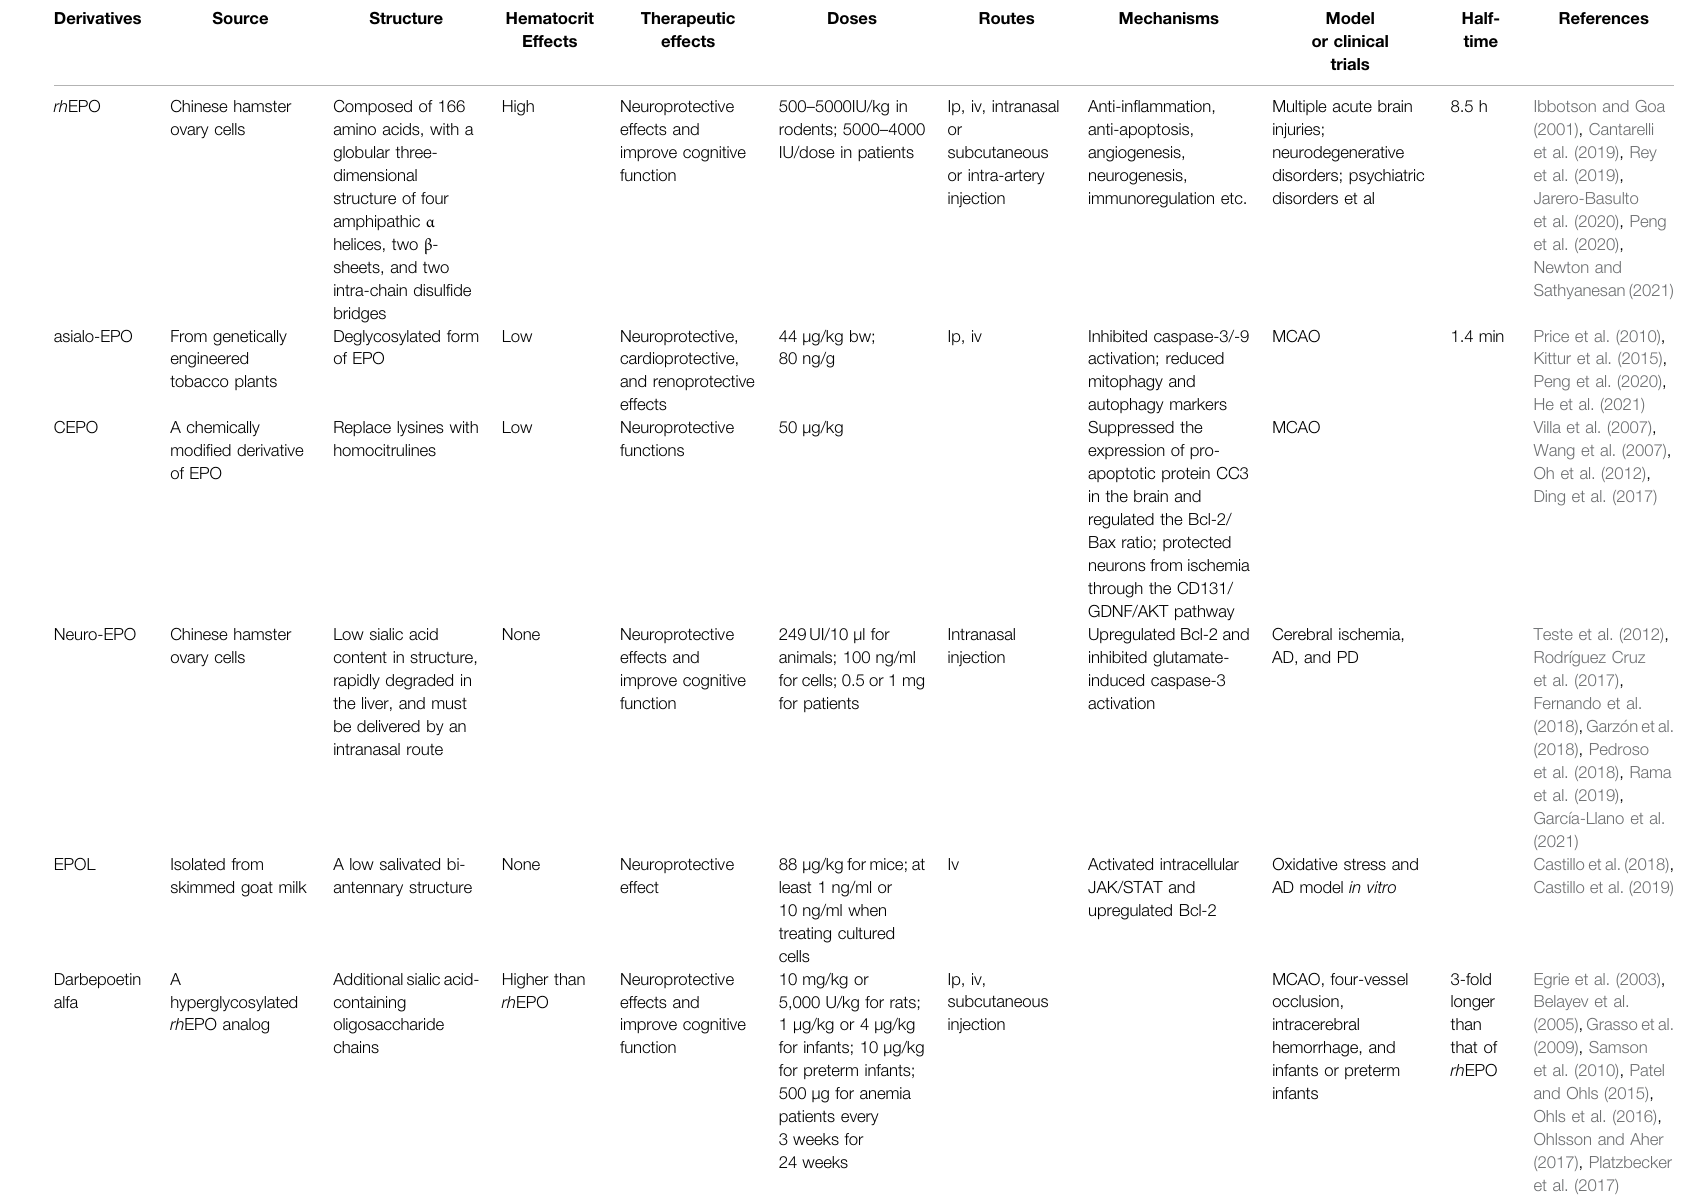
TABLE 2 | Characteristics of different derivatives of rh EPO. Asialoerythropoietin (Asialo-EPO); carbamylated EPO (CEPO); neuro-EPO; EPOL; Darbepoetin